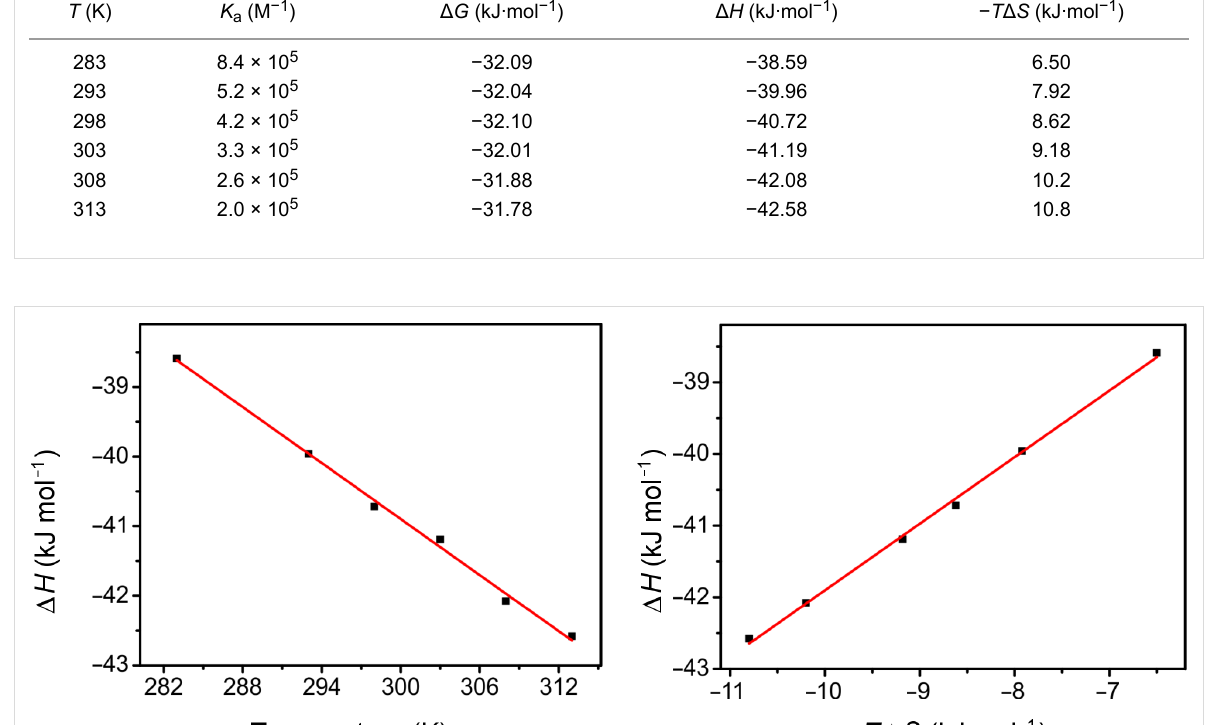
Table 3: Thermodynamic parameters for the complex between 18 + and ZB4 as determined by ITC in a 1:1 mixture of 1,2-dichloroethane and MeCN at different temperatures. T (K)